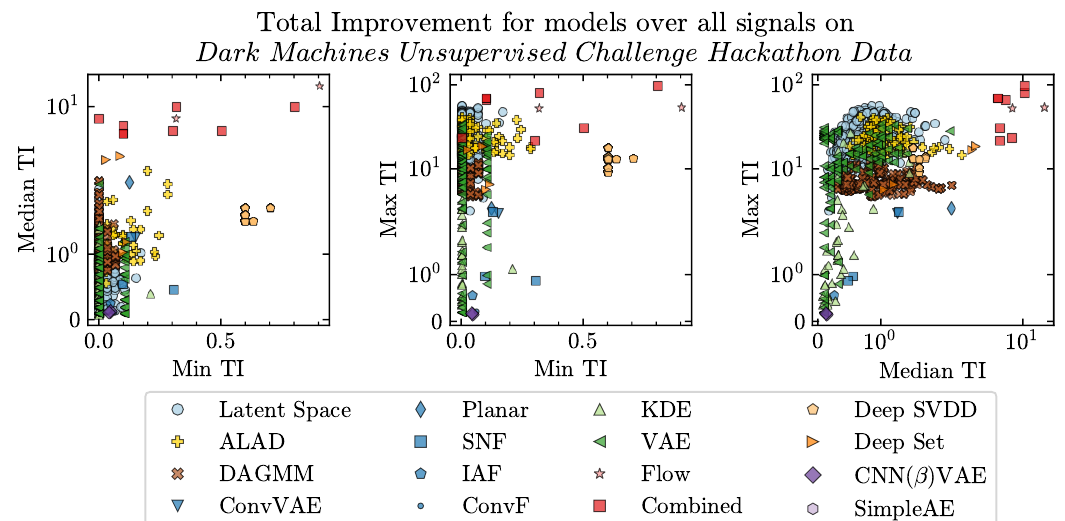
Figure 19: The minimum, median, and maximum best total improvements for each technique across the physics models. The TI is defined as the maximum signal im- provement for a physics model across all signal